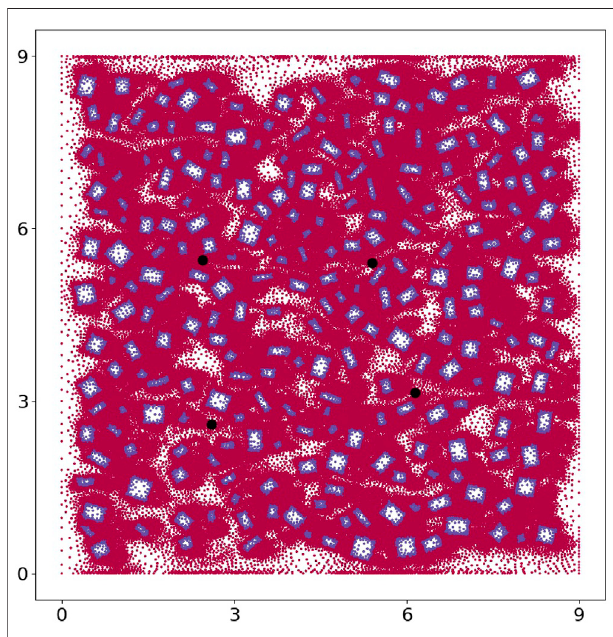
FIGURE 11 | Here we plot all the nodes within the 9 by 9 domain. The nodes within the building appear as blue and those outside of the building as red. We also show four points within the domain, in black, where we plot the histograms, or probability density functions, of the x − and y − components of